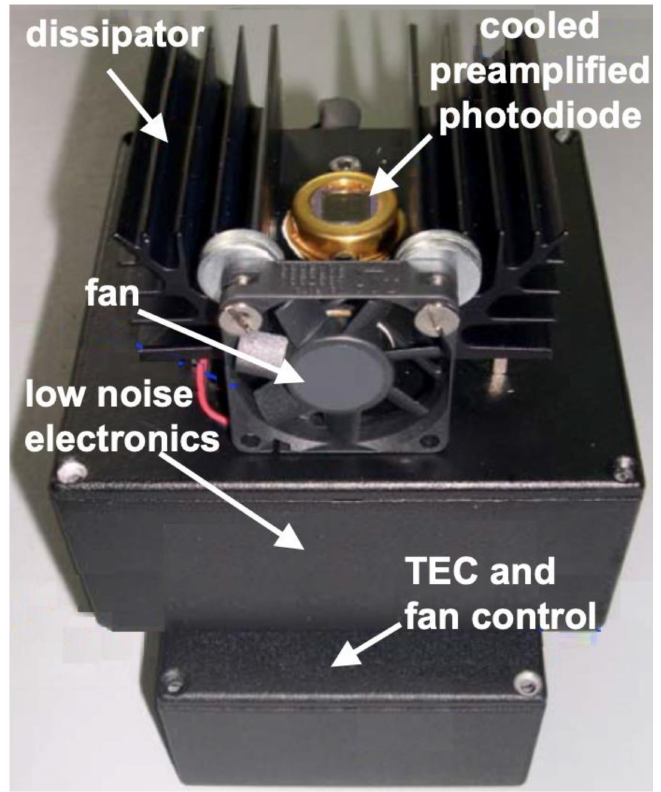
Figure 3. The improved photodiode detection